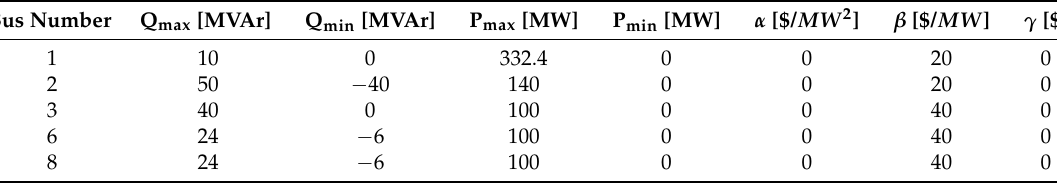
Table A2. IEEE 14-generator data